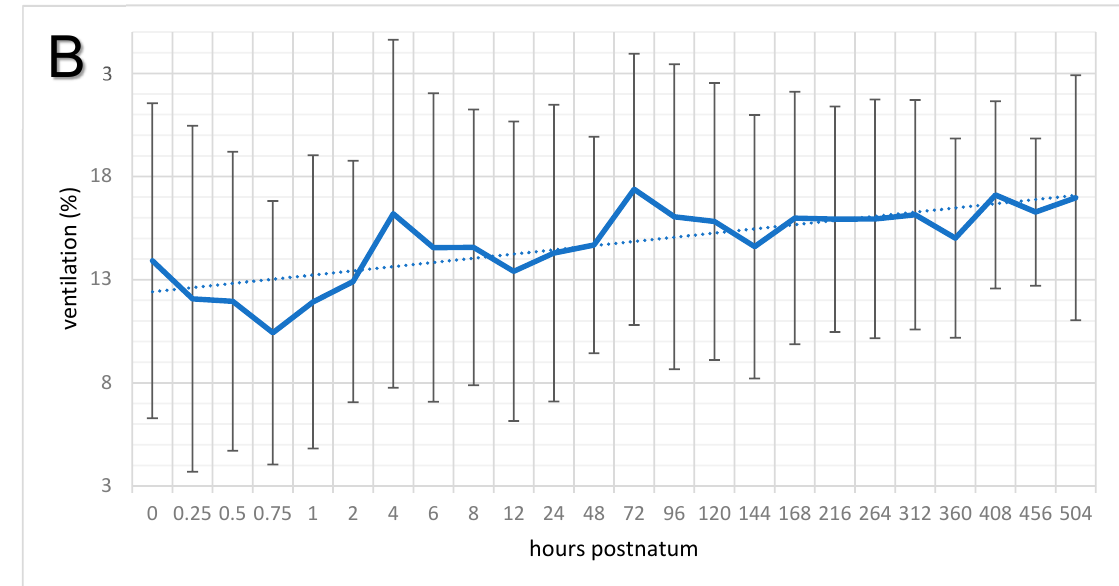
Figure 5. ( A ) Means and standard deviations of ventilation of the right (blue solid line) and left lungs (orange solid line) and trend line (dotted) in 20 neonatal calves. The measuring times are graphed equidistantly. ( B ) Means and standard deviations of the ventilation of the centrovental lung region of the left lung (solid line) and trend line (dotted) in 20 neonatal calves. The measuring times are graphed equidistantly.